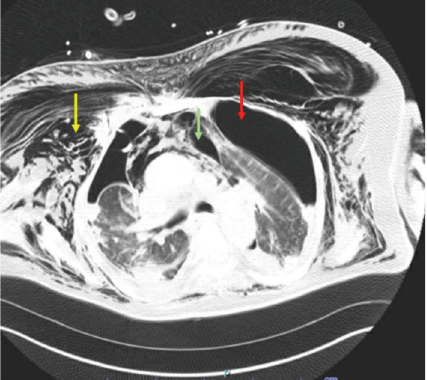
Figure 3: CT scan of the chest showing left-sided tension pneumothorax (red arrow), right-sided pneumothorax, pneumomediastinum (green arrow), and extensive subcutaneous emphysema of the chest wall (yellow arrow) with an indwelling right-sided chest tube.